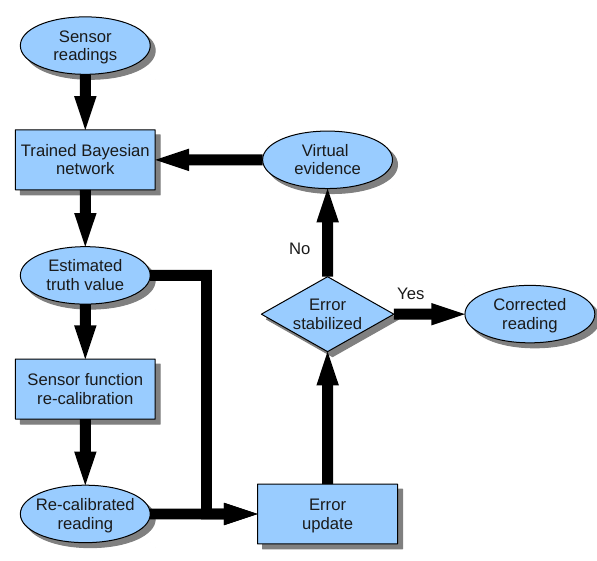
Figure 1. System